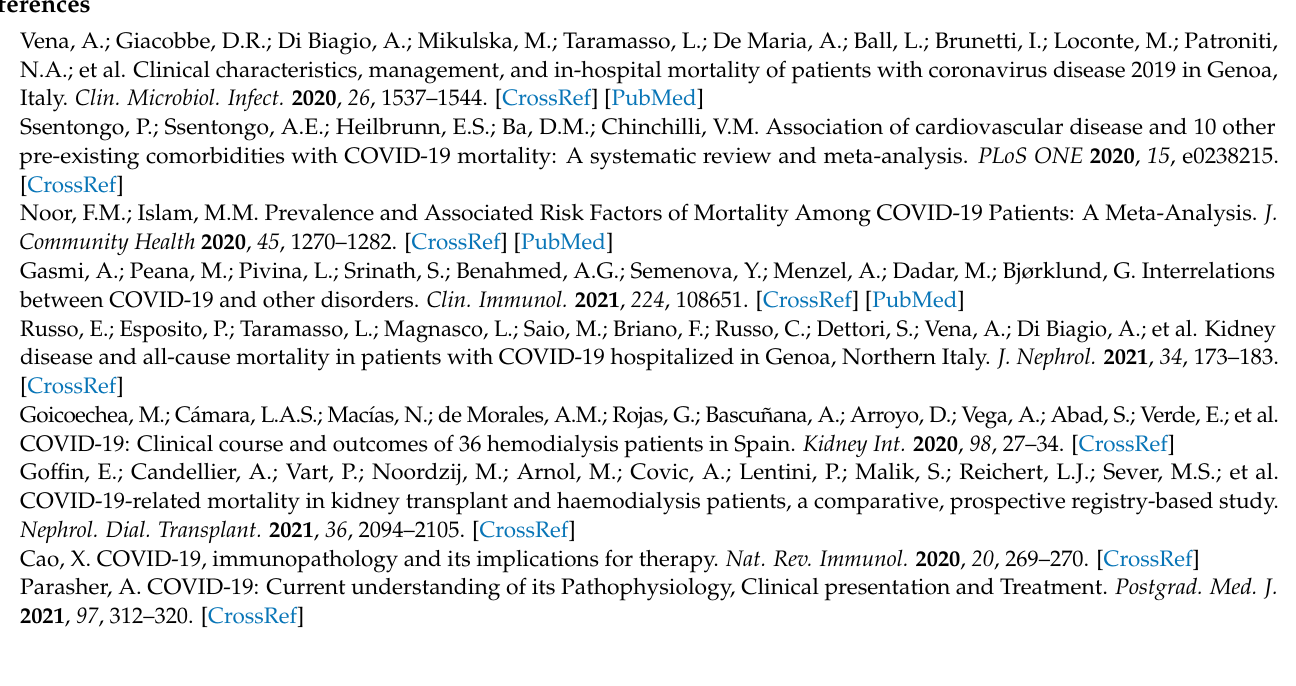
Table S3: time course of laboratory parameters in hemodialysis patients affected by COVID-19 during different periods, Table S4: clinical outcomes of hemodialysis patients affected by COVID-19 according to the response to the second dose of COVID-19 mRNA